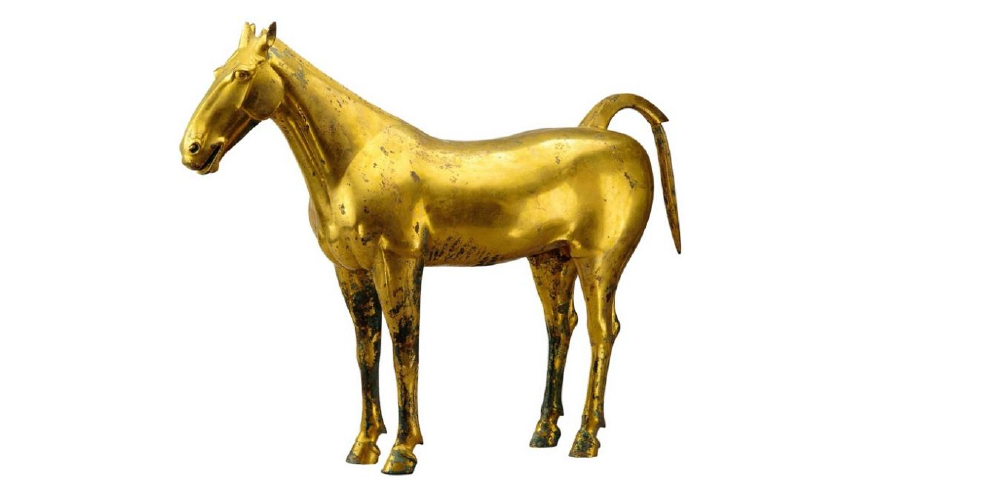
Figure 3. Gilded bronze horse from the Western Han Dynasty. Materials: gilt bronze. Dimensions: H. 62 cm x W. 76 cm. Displayed in Maoling Museum, Shanxi Province, China. Photo source: the official website of the Suzhou Museum. 8 .